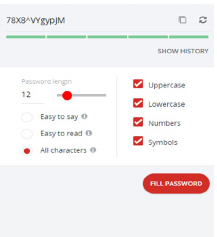
Figure A16. Random password generator for